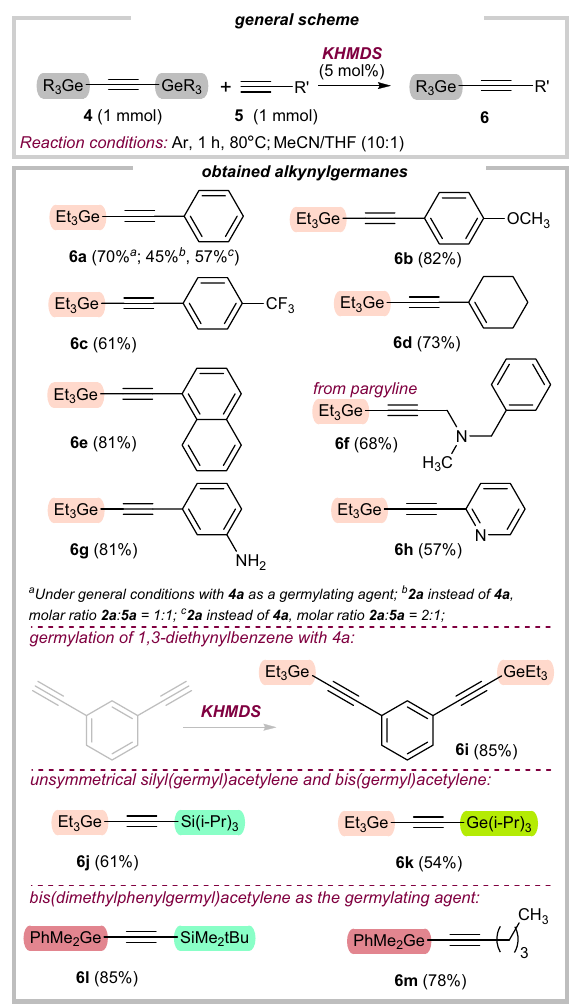
Figure 4. Substrate scope for C–germylation of terminal